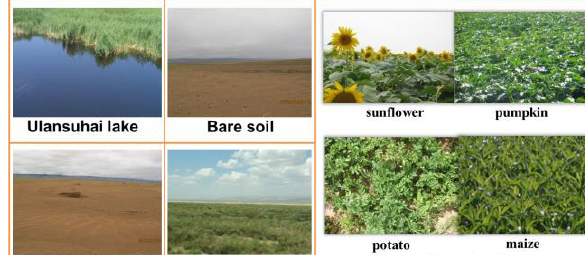
Figure 1. Location of Baotou site